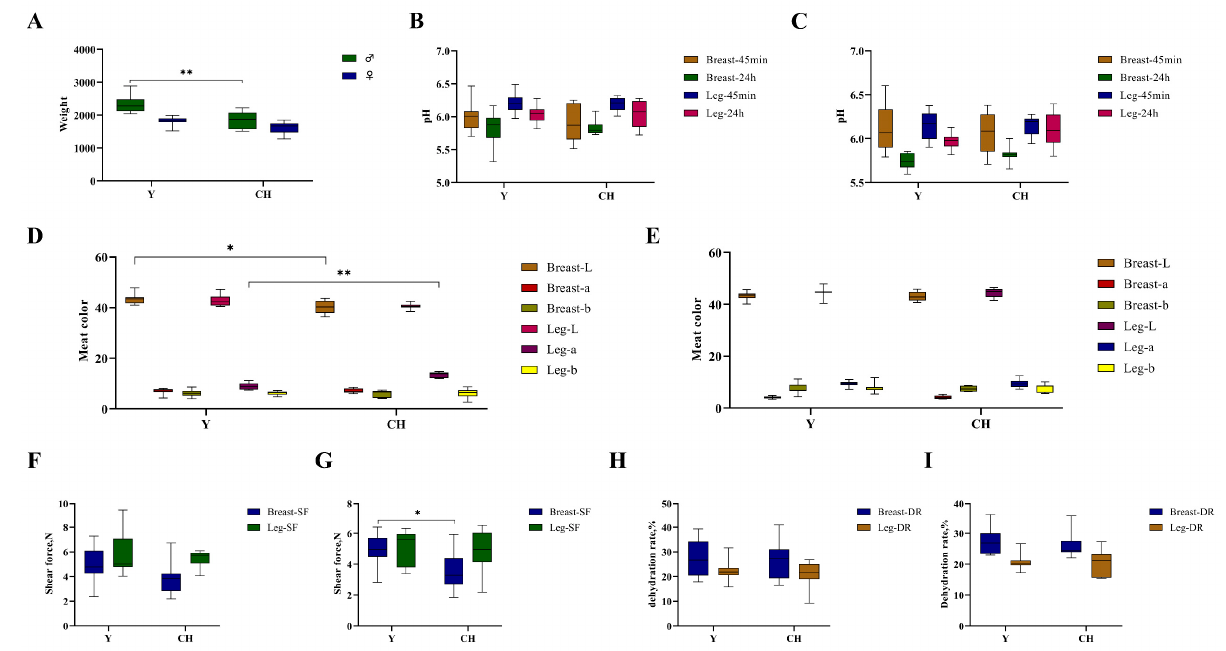
Figure 1. Comparison of body weight and meat quality physical indexes between Y and CH. ( A ) Comparison of body weight of two chicken breeds. ( B ) Comparison of pH values between two males. ( C ) Comparison of pH values between two females. ( D ) Comparison of meat color between two males. ( E ) Comparison of meat color between two females. ( F ) Comparison of shear force between two males. ( G ) Comparison of shear force between two females. ( H ) Comparison of dehydration rate between two males. ( I ) Comparison of dehydration rate between two females. ** indicates extremely significant differences ( p < 0.01); * indicates significant difference ( p < 0.05)